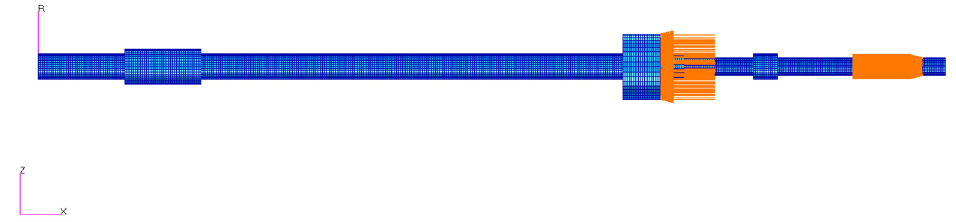
Figure 13. Preload. Figure 13. Preload.